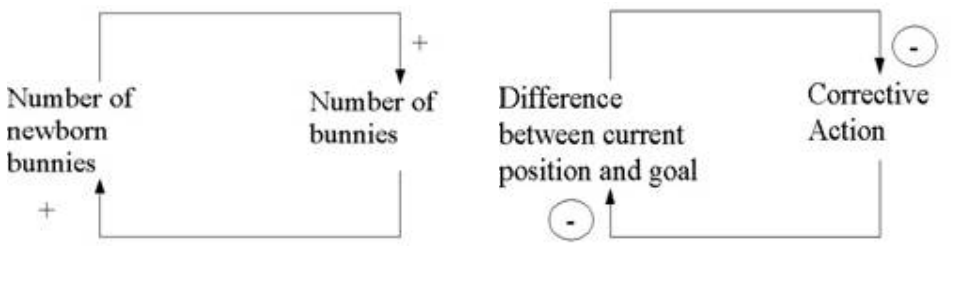
Figure 2. Positive and negative causal loop diagrams